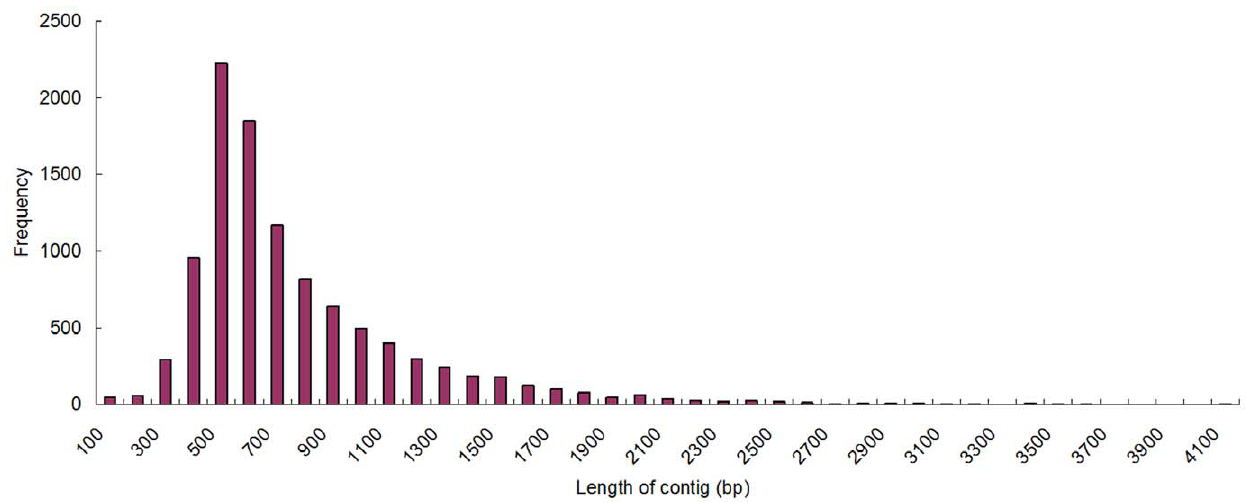
Figure 1. Distribution of the lengths of the ESTs for Unigenes of Fujian Oyster by 454 sequencing.